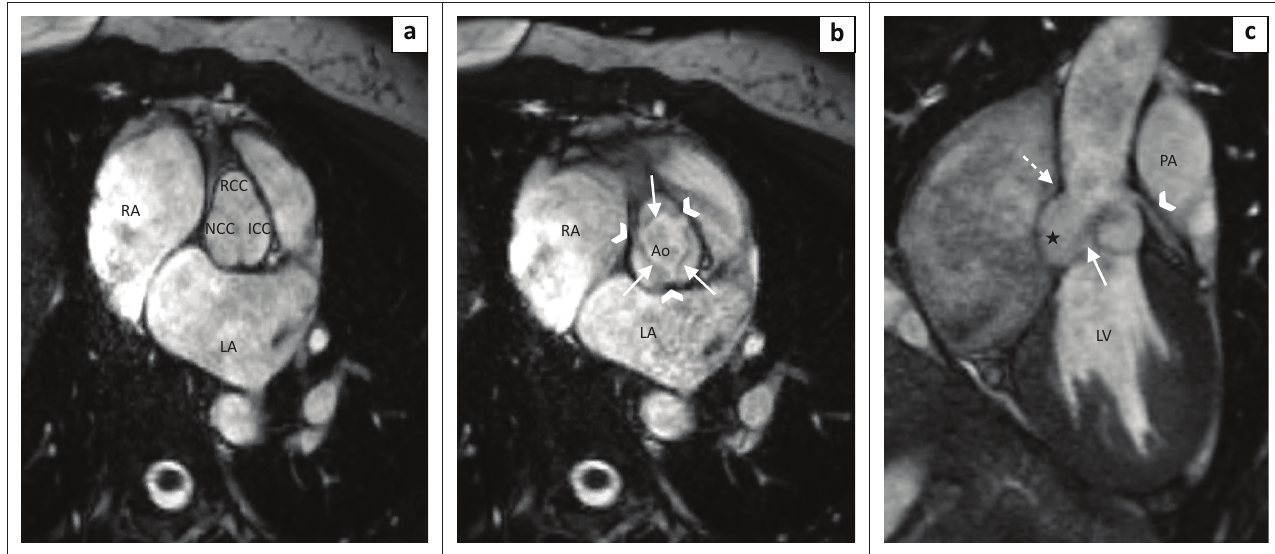
FIGURE 2: (a) Axial cine SSFP image through the aortic valve in diastole demonstrates a closed valve with three valve cusps: the right coronary cusp (RCC), the left coronary cusp (LCC) and non-coronary cusp (NCC). The left atrium (LA) and right atrium (RA) are also identified; (b) Axial cine SSFP image through the aortic valve in systole demonstrates an open valve with the cusp leaflets (white arrows) and the commissures between the cusp attachments (arrowheads). The aorta (Ao), left atrium (LA) and right atrium (RA) are identified. (c) Coronal SSFP cine image of the aortic valve demonstrates the aortic cusp (white arrow), the coronary sinus ( * ) and the sinotubular junction (dashed arrow) and the coronary artery coming off the coronary sinus (arrowhead). The left ventricle (LV) and pulmonary artery (PA) are